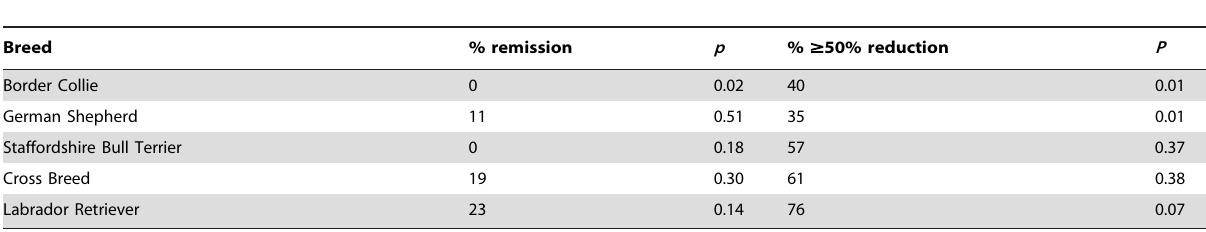
Table 5. Top five breeds most likely to lack drug response.